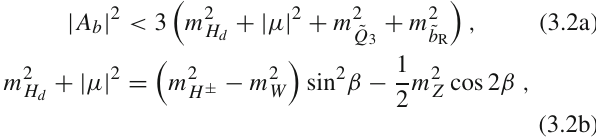
In Fig. 2 the predictions of FeynHiggs (dashed: MSSM with real parameters, dotted: MSSM with complex param- eters) are compared to our new result (solid) as a function of m A . The different colors correspond to different values of t β . The large deviations between the dashed and dotted (cid:3) (cid:2) α α + α 2 curves for large values of t β are induced by the O t b b terms, which are not incorporated in the dotted curve. After adding our new contributions to the result for complex parameters the agreement with the FeynHiggs result for the case of real parameters is very good, i.e. the dashed and solid lines almost coincide with each other. Since the (cid:3) (cid:2) α + α 2 α corrections which is version of the O t b b